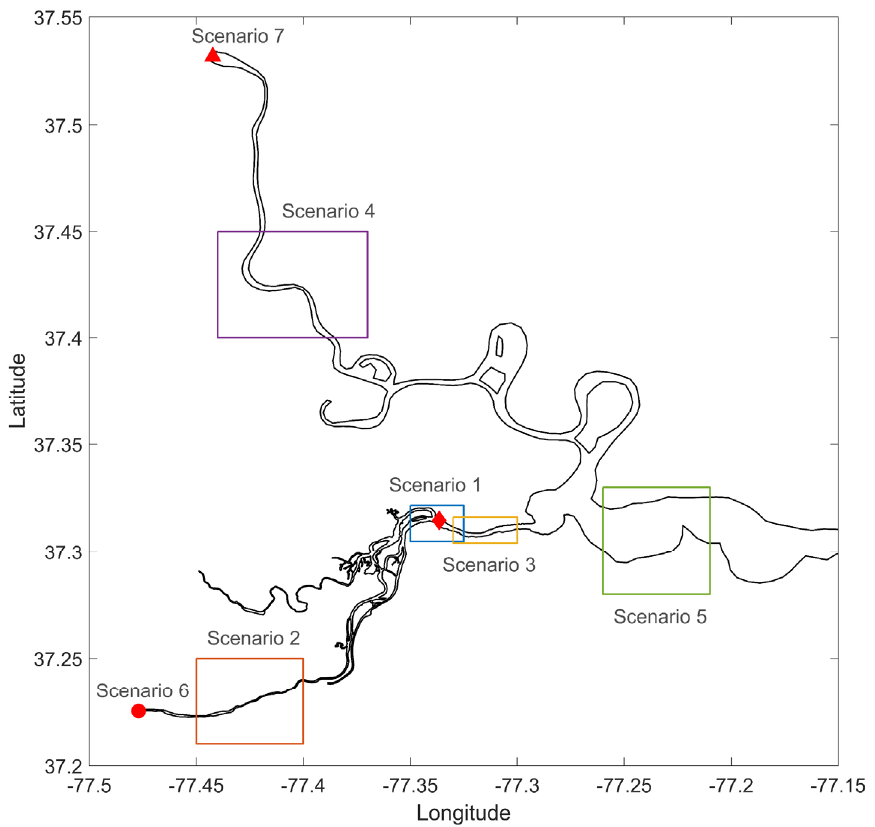
Figure 3. Map showing the release locations of particles for the seven scenarios of the forward particle tracking model (scenarios 1–7). The red diamond shows the location of the intake. Table 2. The release method, location, flow condition, and vertical velocity of the 34 forward particle tracking scenarios. In those scenarios where particles are released continuously, the release period is 21 days, and the number of particles released is proportional to daily freshwater discharge. The vertical velocity of the particle can be either upward (+) or downward ( − ).